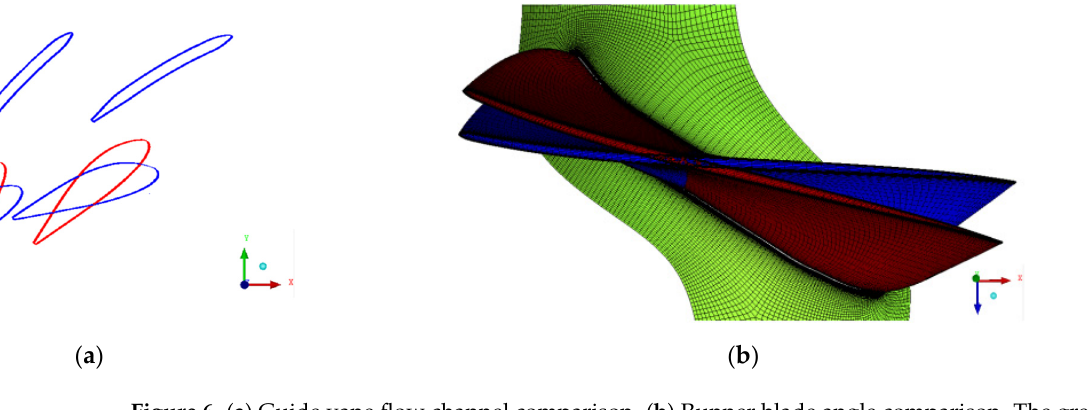
the runner blade clearances was included.